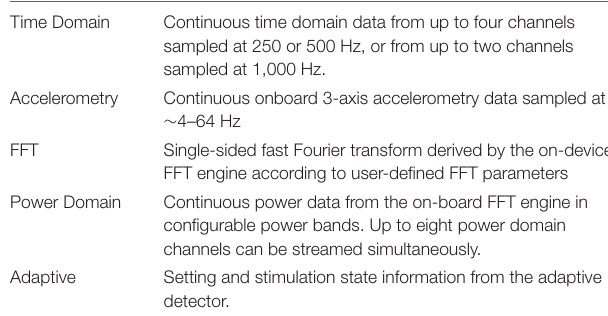
TABLE 2 | Summit RC + S configurable data